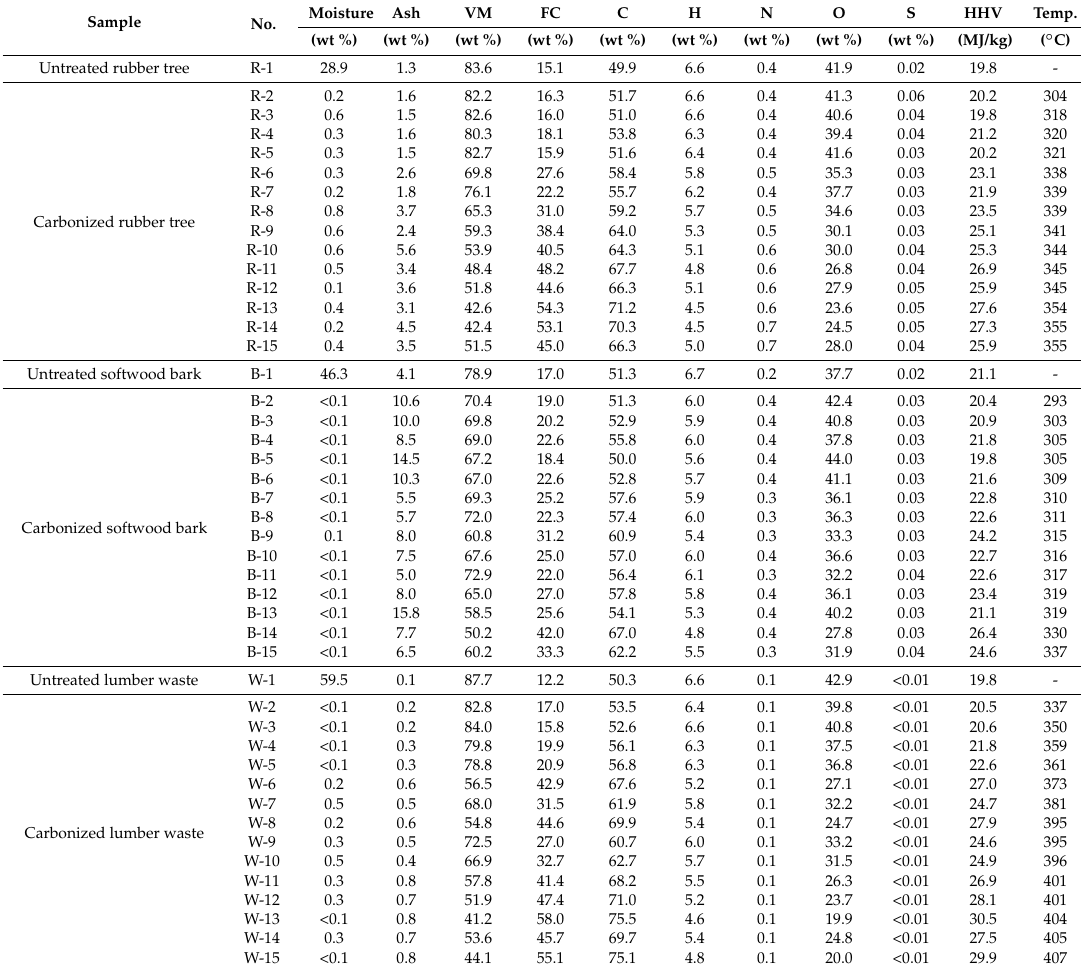
Table 1. Fuel properties of raw and carbonized WB